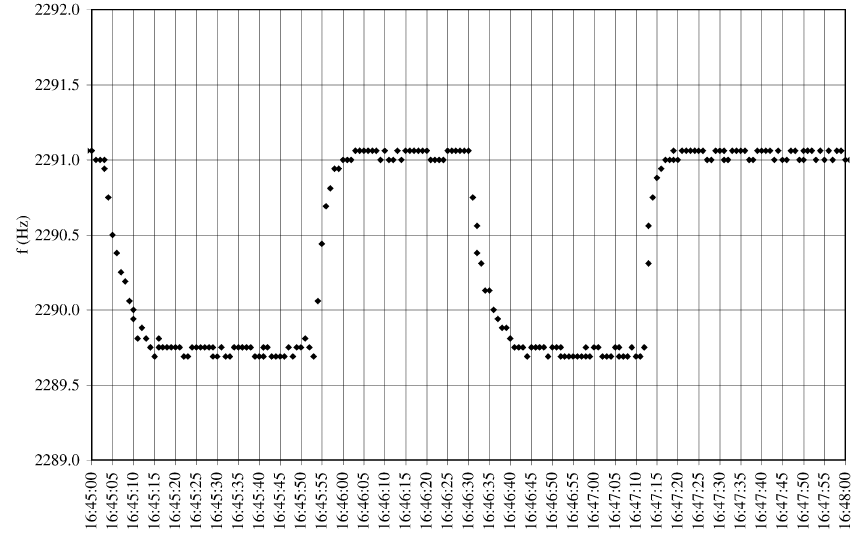
FIG. 6. Transient characteristics of the wire oscillation frequency at switching on /off current I (cid:1) 215 mA through the wire. One end of the wire is free.